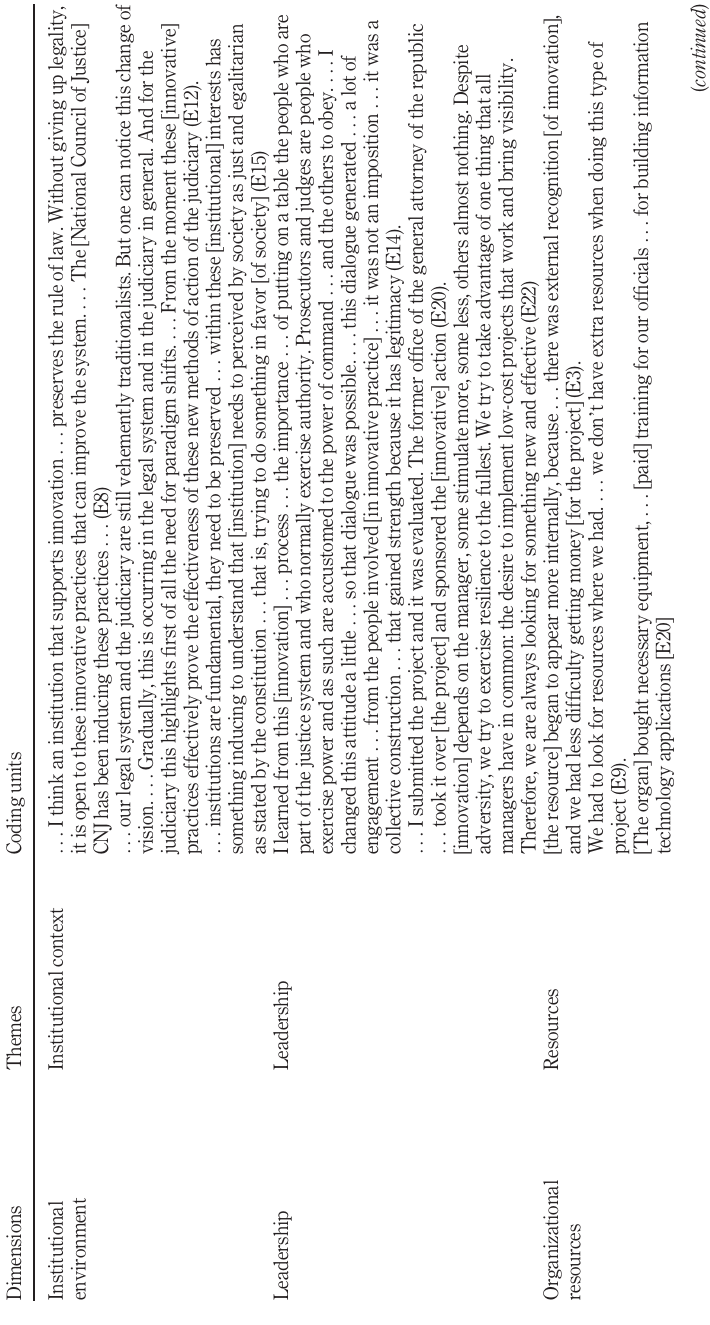
Table II. Dimensions, themes and coding